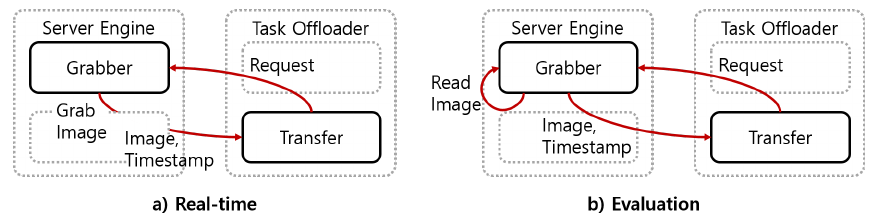
Figure 10. Operation of the server engine module in the real-time and evaluation experiment.